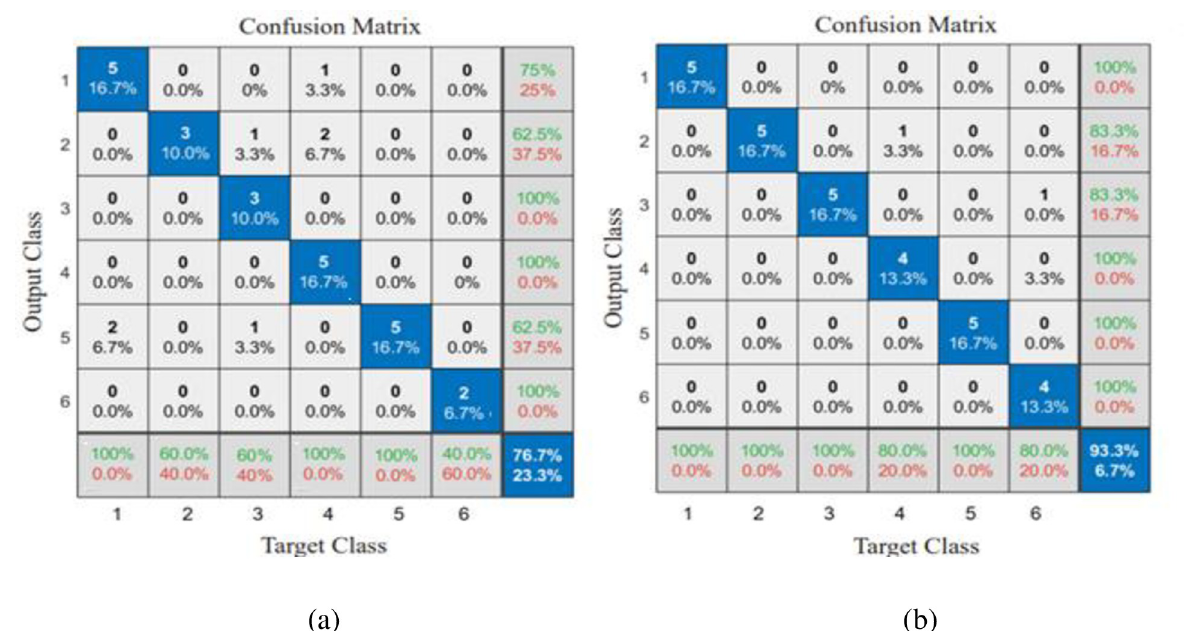
Fig 11. Confusion Matrix (a) DCNN without fusion (b) DCNN with fusion.